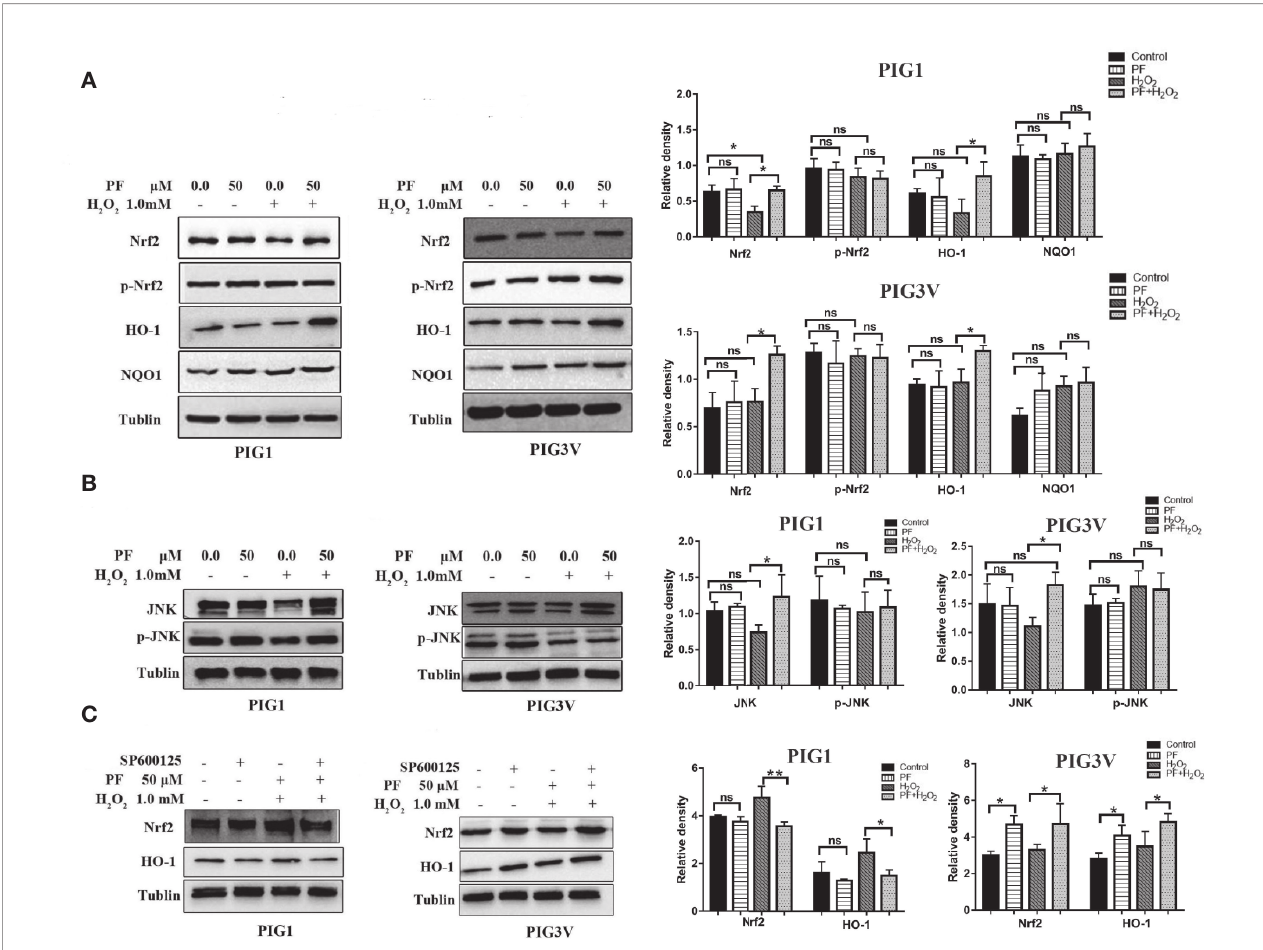
FIGURE 6 | PF activates JNK/Nrf2/HO-1 pathway in H 2 O 2 -treated melanocytes. Melanocytes were treated with PF for 24 h and further treated with H 2 O 2 for another 24 h. (A) Western blots of total Nrf2, p-Nrf2, and its downstream antioxidant enzymes, NQO1, and HO-1 . (B) The protein levels of JNK and p-JNK , (C) The levels of Nrf2 and HO-1 proteins in melanocytes treated with SP600125 and PF followed by H 2 O 2 . The quantitative analysis of Nrf2, p-Nrf2, NQO1, and HO-1 (A) , JNK and p-JNK (B) , and Nrf2 and HO-1 (C) using Tublin as normalization were showed at the right, respectively, all data are presented as mean ± standard deviation. n = 3 per group, * P < 0.05, ** P < 0.01, ns, not signi fi cant; H 2 O 2 , hydrogen peroxide; PF, Paeoni fl orin; M, mol/L; h, hours; JNK , c-Jun N-terminal kinase. p-,